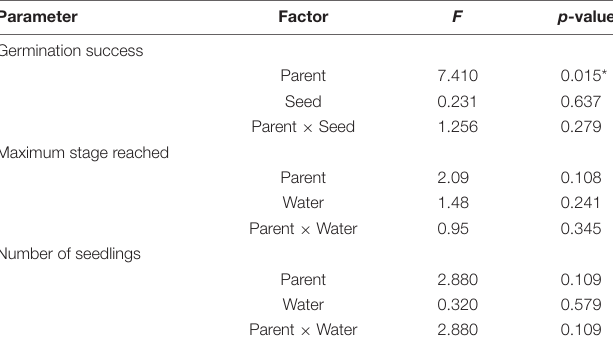
TABLE 4 | Results of two-way ANOVAs testing for parental (parent) and direct (seed) CO 2 effects on germination success, seedling maturation (as maximum stage reached), and number of seedlings produced (Experiment 2).